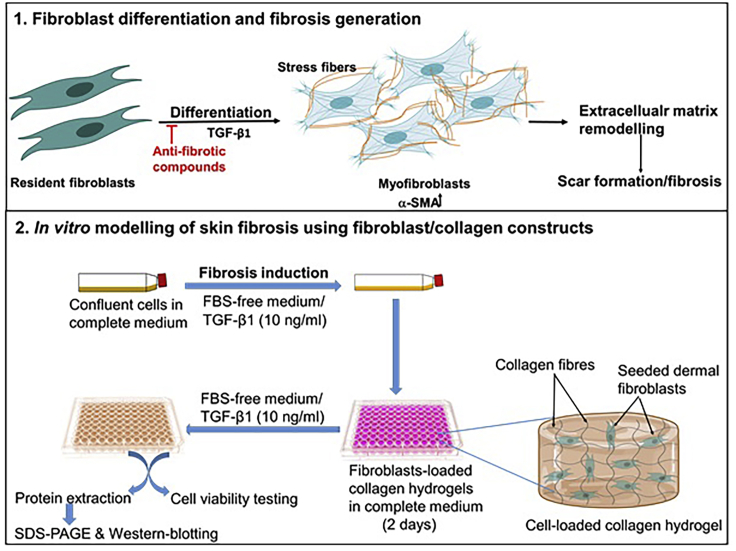
Fibroblasts and fibrosis(1) The origin and function of myofibroblasts in the skin fibrotic microenvironment (Luzina and Atamas, 2008; Rinkevich et al., 2015; Bochaton-Piallat et al., 2016). (2) In vitro modelling of skin fibrosis using fibroblast/collagen constructs. Abbreviations: TGF-β1, Transforming Growth Factor-Beta 1; α-SMA, alpha smooth muscle actin.